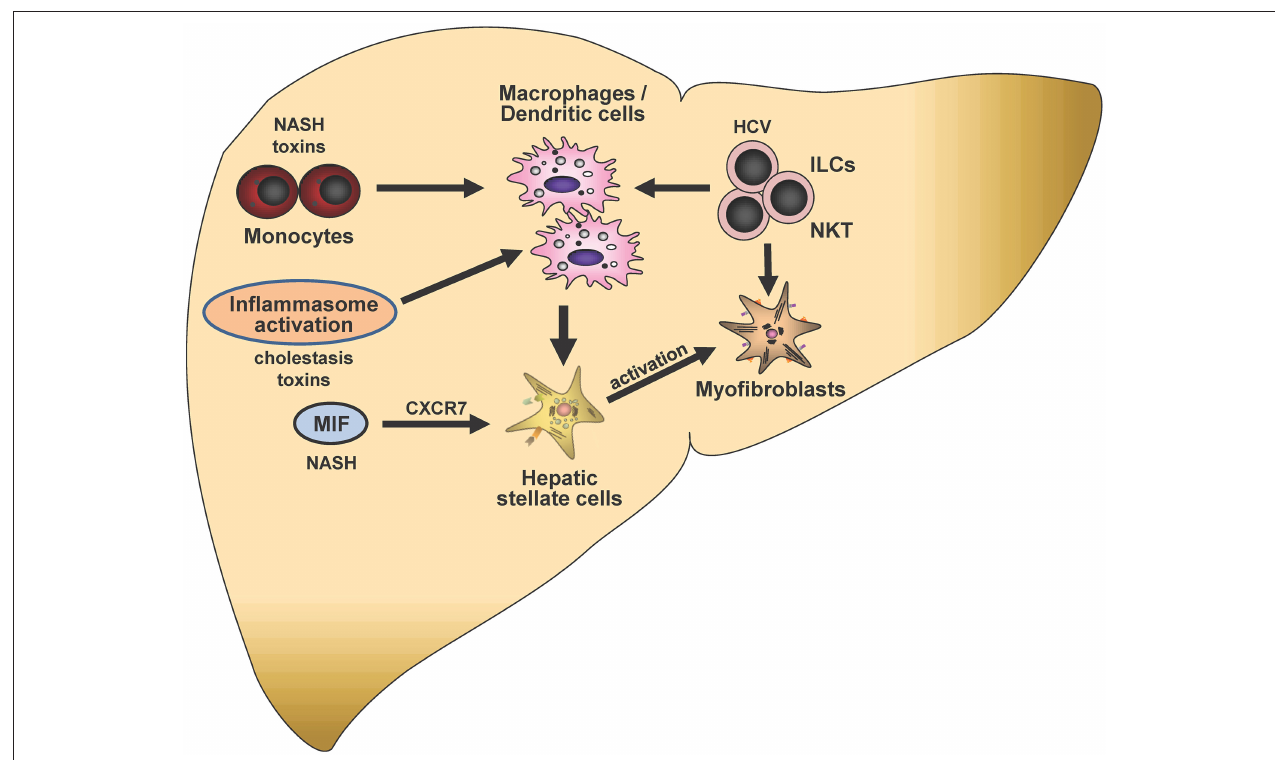
FIGURE 5 | Immunological mechanisms in liver fibrogenesis. Selected potential signaling pathways and proposed cell-cell interactions discussed in this article are shown schematically. Mediators and triggers are depicted in smaller font size as follows: NASH, non-alcoholic steatohepatitis; CXCR7, CXC chemokine receptor type 7; HCV, hepatitis C virus; ILCs, Innate lymphoid cells; NKT, Natural killer T-cells; MIF, Macrophage migration inhibitory factor. In the center of this chapter is the potential crosstalk of monocytes, macrophages, hepatic stellate cells and ILCs, which can be modulated by distinct triggers such as NASH, toxins, inflammasome activation or HCV infection. Crosstalks may eventually lead to modulation of stellate cell activation and subsequent liver